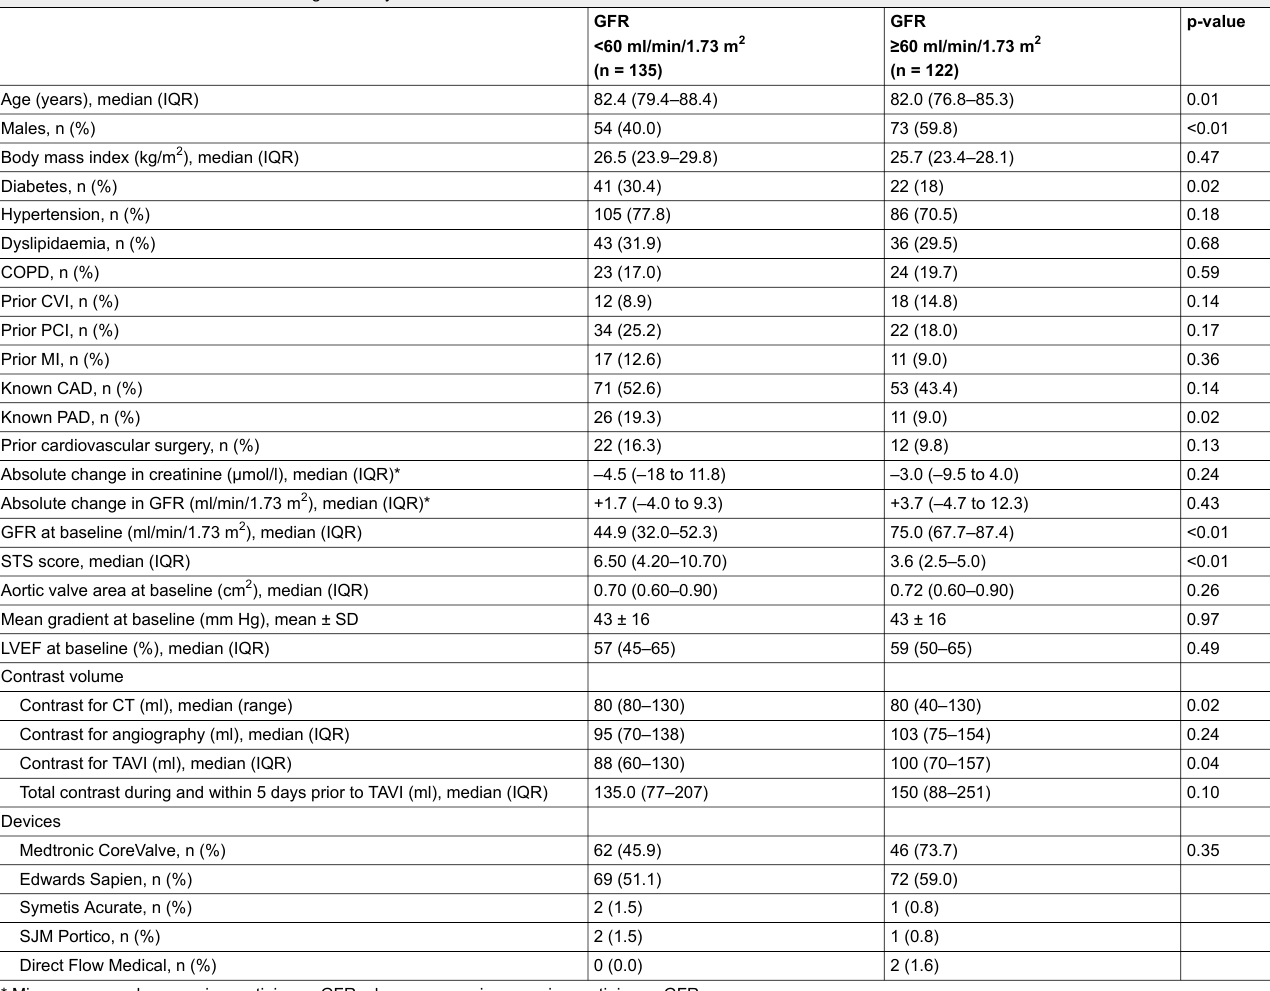
Table 1b: Patient characteristics according to kidney function at baseline.